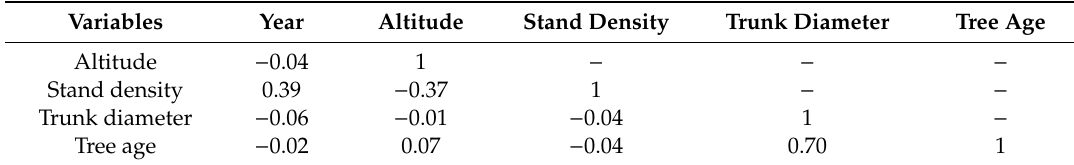
Table 2. Correlation among selected predictor